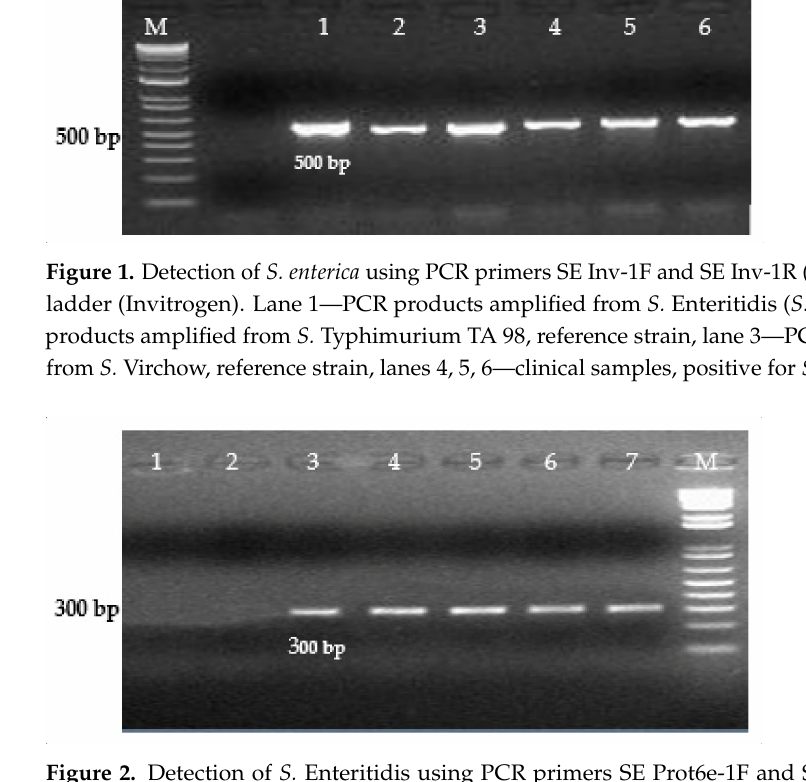
Figure 2. Detection of S. Enteritidis using PCR primers SE Prot6e-1F and SE Prot6e-1R (300 bp). Lane M—1kb ladder (Invitrogen). Lane 1— S. Typhimurium (S.t-0072), lane 2— S. Virchow (ref- erence strain), lane 3—PCR products amplified from S. Enteritidis (S.e-0071) (positive control), lanes 4, 5, 6, 7—clinical samples, positive for S.